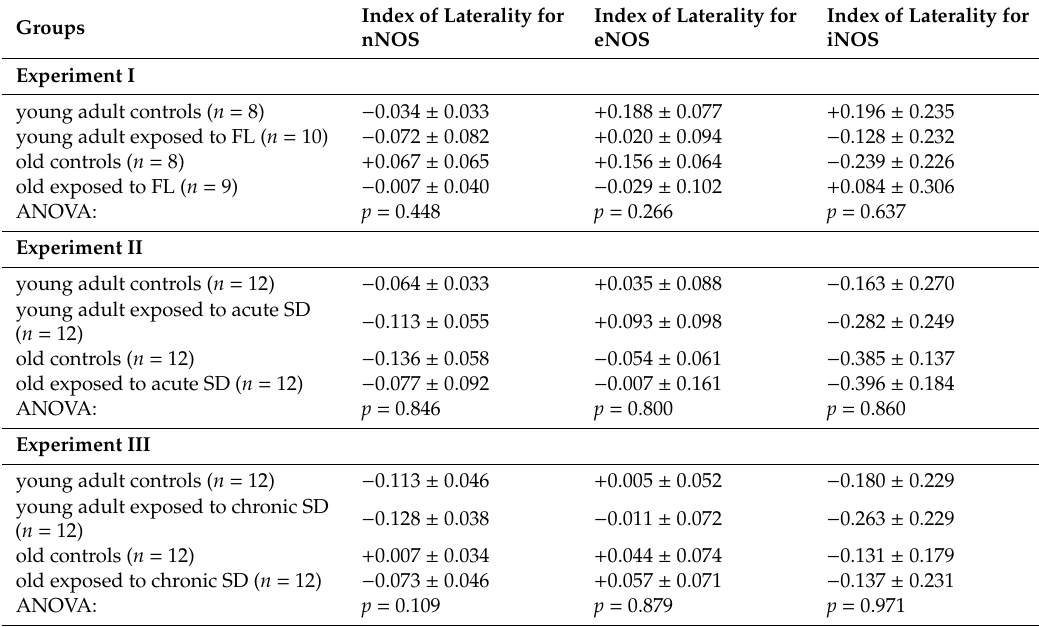
Table 1. Indexes of laterality of activities of NOS isoforms in the R and L parietal